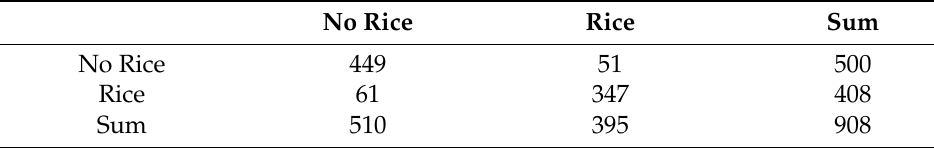
Table 10. Confusion matrix for the entire time